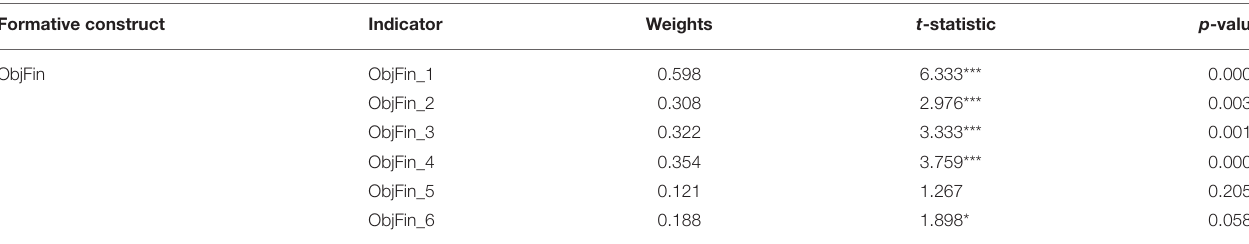
TABLE 6 | Significance and relevance of formative construct ObjFin iteration